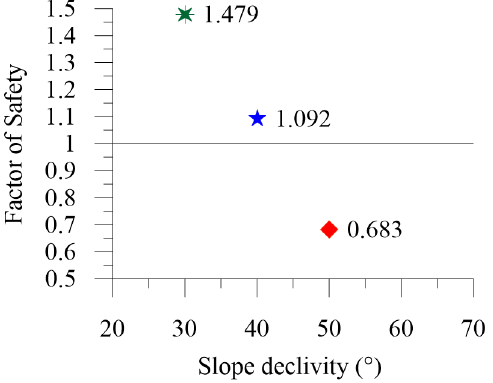
Figure 3. Factor of safety variation with slope declivity.